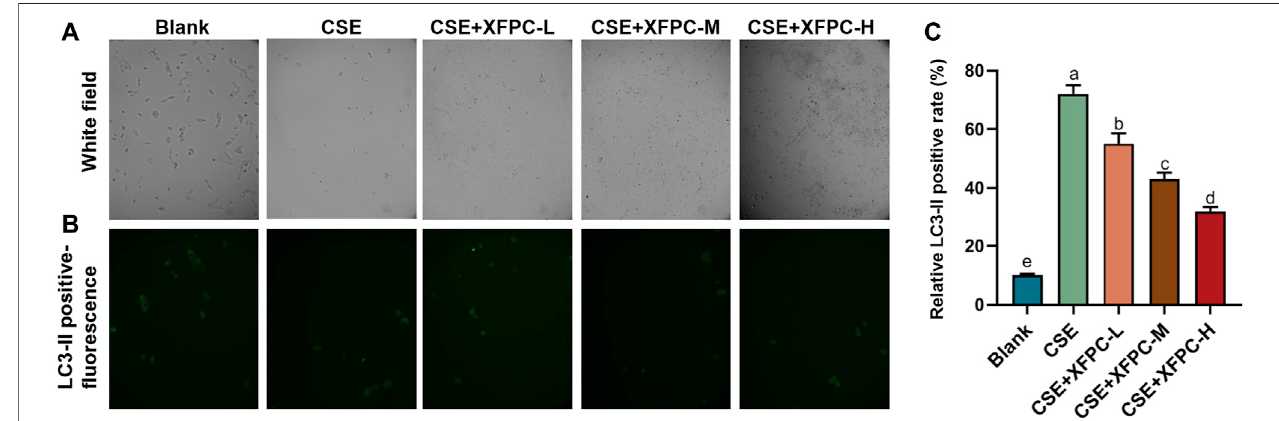
FIGURE 2 | XFPC signi fi cantly reduces the autophagy levels of CSE-HBE cell model. (A) The cell morphology of HBE cells treated with CSE and different concentrations of XFPC. (B) The formation of LC3-II puncta in each group corresponding with panel (A) were analysed by immuno fl uorescence under microscopy ( × 200). (C) The relative LC3-II positiverate indicating level ofautophagy wasshown.Lowercaseletters indicate statistically signi fi cantdifferences ( p < 0.05) accordingto ANOVA followed by Tukey ’ s HSD test. XFPC, Xuanfei Pingchuan Capsules; CSE, cigarette smoke extract; HBE cells, human bronchial epithelial cells.